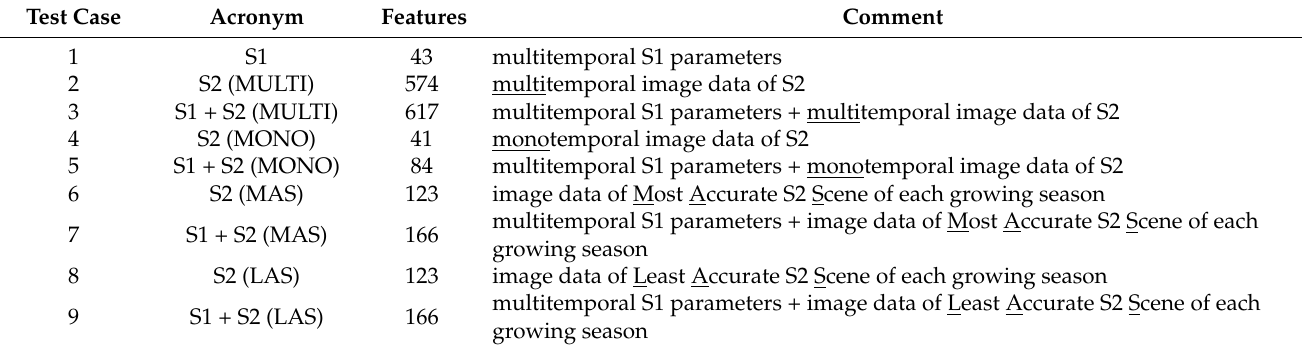
Table 5. Scenario of the nine test cases evaluated using different combinations of Sentinel-1 (S1) and Sentinel-2 (S2)